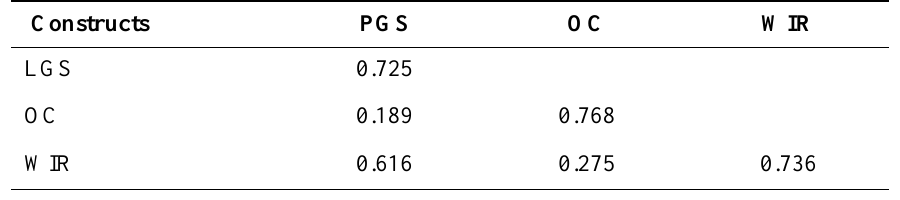
Table.3. Discriminant Validity